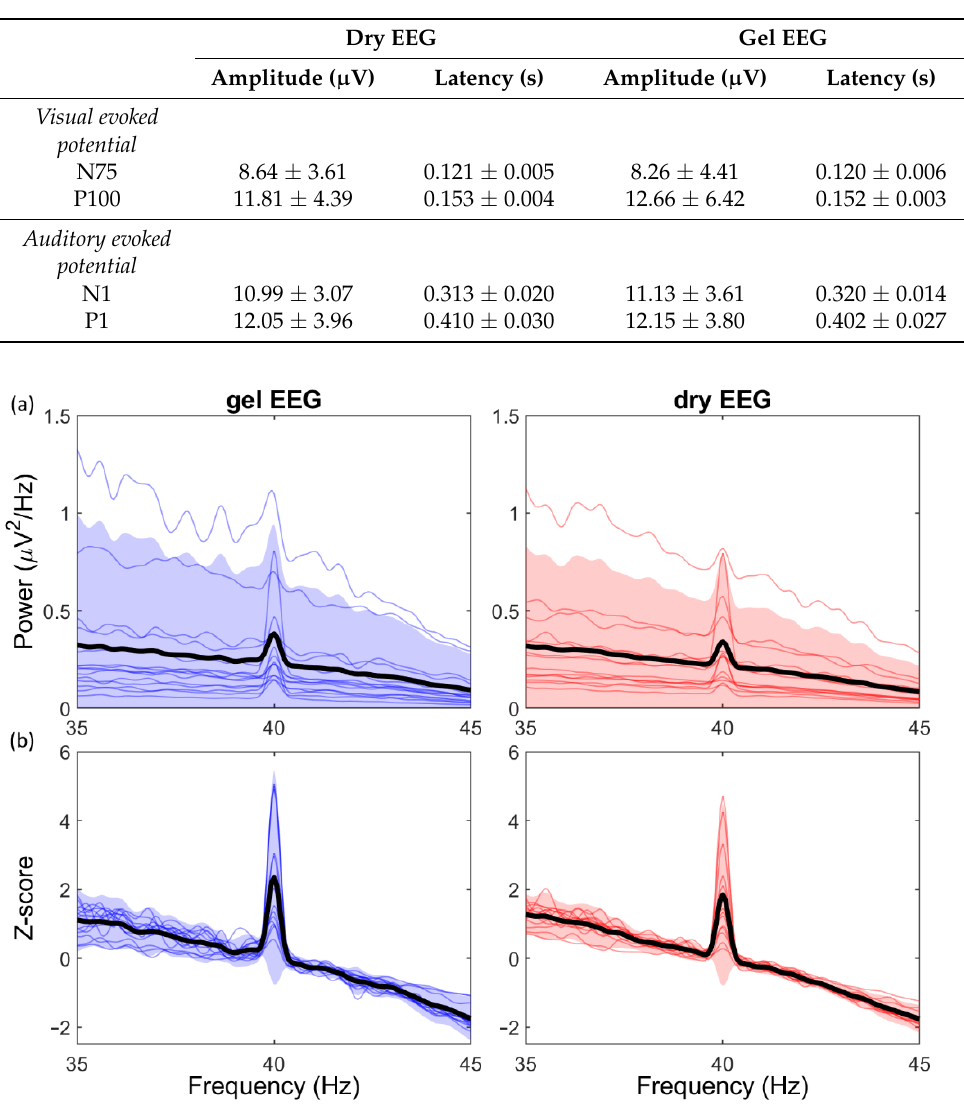
Figure 4. Power spectral density (PSD) of the 40 Hz Auditory steady-state response (ASSR) for the gel EEG system (blue; left) and dry EEG system (red; right). ( a ) Absolute PSD of the 40 Hz-ASSR ( μ V 2 /Hz), averaged over channels per subject. ( b ) Standardized PSD of the 40 Hz-ASSR (Z-score), averaged over channels per subject. Black lines indicate average PSD over all subjects and channels; shaded areas indicate the confidence interval (mean ± 2xSD).